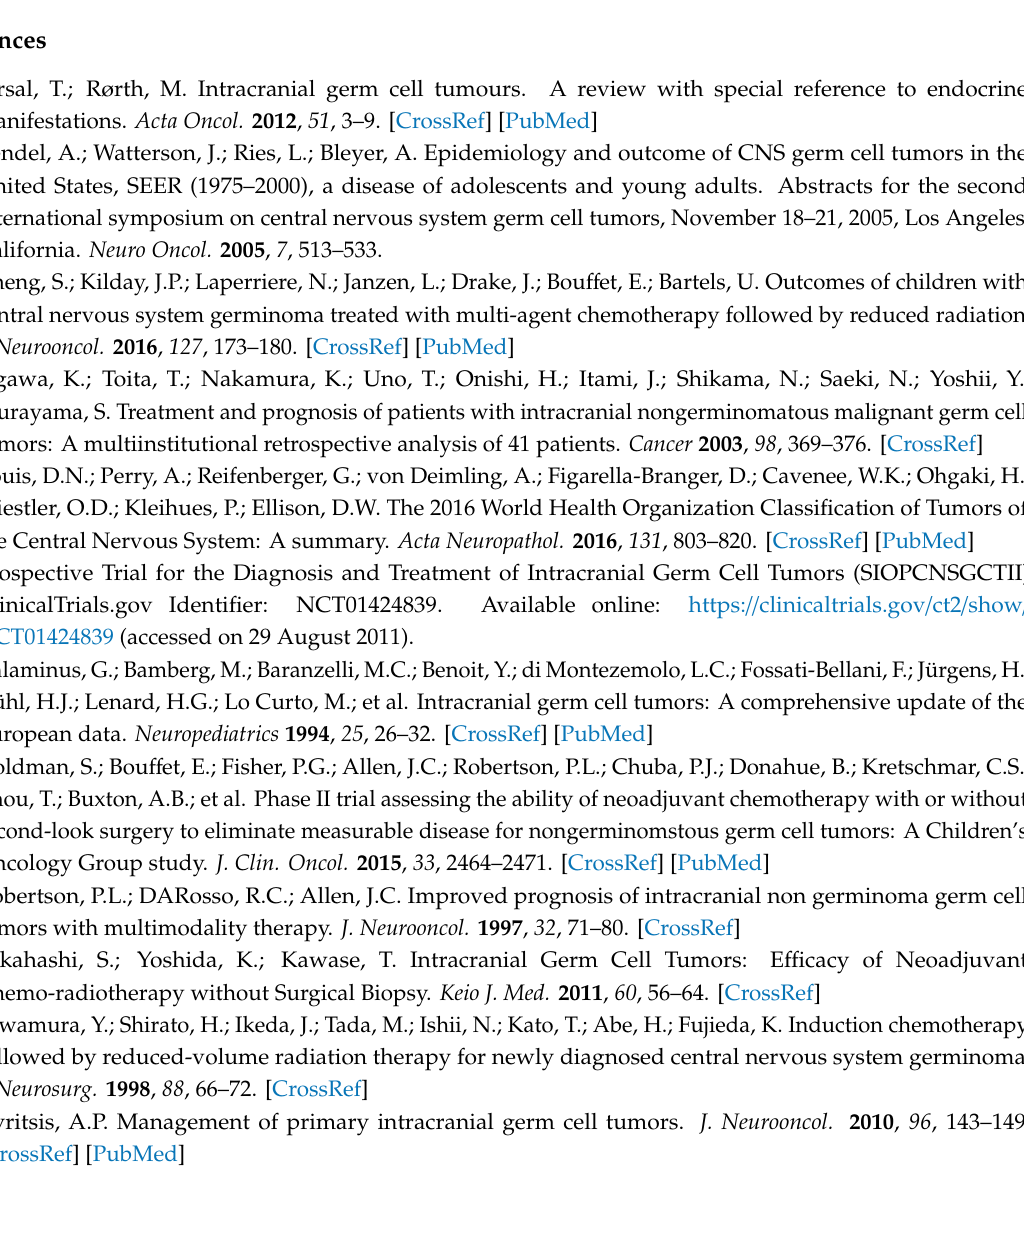
Table S1: Details of chemotherapy and radiotherapy; Table S2: Radiotherapy details; Table S3: High-risk patients; Table S4: Neurocognitive evaluations: demographical characteristics of the sample; Table S5: Neurocognitive evaluations: mean scores of neurocognitive abilities of patients and normative